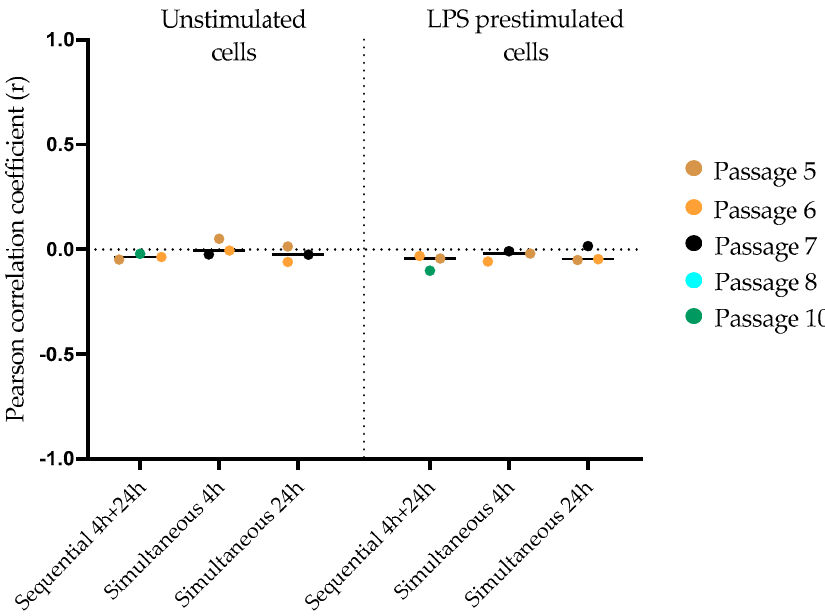
Figure 6. The colocalization between SiO 2 particles of different sizes was analyzed using Imaris software. The Pearson correlation coefficient (PCC) revealed no correlation/signal overlap between both particles for all co-exposure conditions.